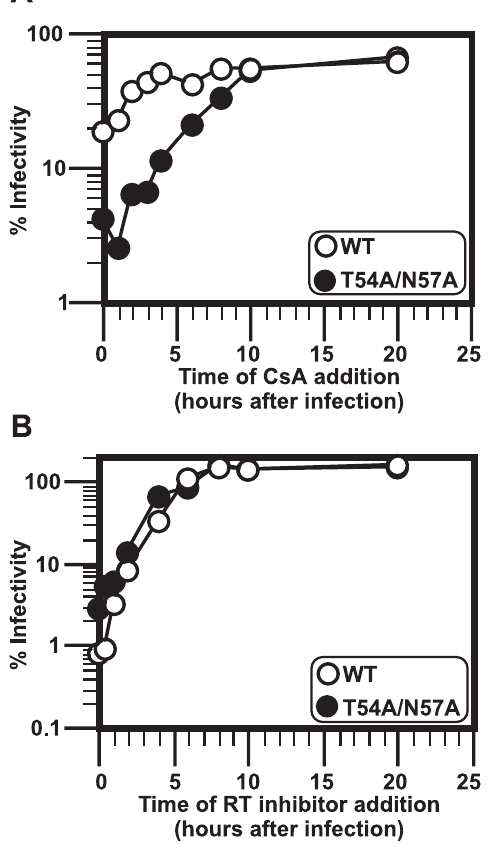
Figure 5. Kinetics of HIV-1 Sensitivity to CsA (A) CsA affects HIV-1 with the CA mutation T54A/N57A much longer than HIV-1 with WT CA. Human T cell Jurkat cells were infected with replication-competent HIV-1 virus encoding the WT envelope and the luciferase gene, which contains either the WT CA sequence or the T54A/ N57A mutation. CsA was added to the well at indicated time points. Virus was added at 8 8 C by spinolculation, and infections were synchronized by washing off the innocula and adding media at 37 8 C. The relative percentage of infectivity was determined by assigning the luciferase value of the sample without CsA as 100% for each virus. White circles indicate WT, black circles the mutant (T54A/N57A). Similar results were observed in three independent experiments. (B) Reverse transcription (RT) of T54A/N57A progresses similarly to that of WT. Similar experiments were done as above (A), except that nevirapine (50 l M) was added instead of